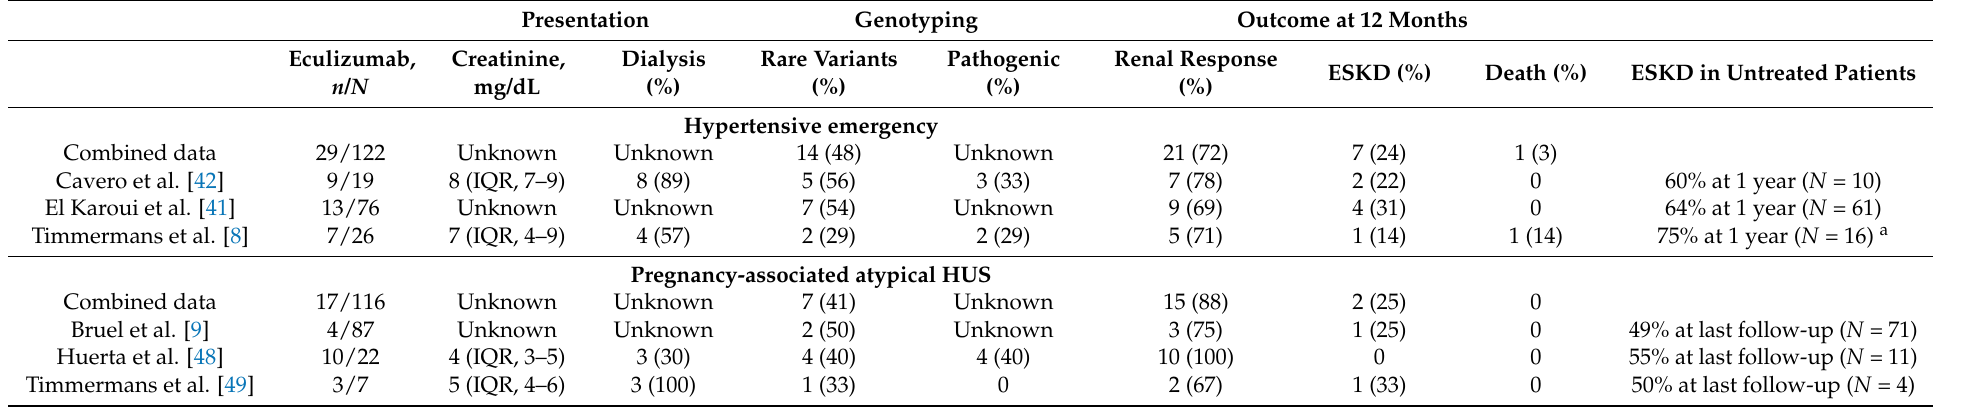
Table 1. The effects of therapeutic complement inhibition in patients with TMA and coexisting hypertensive emergency or pregnancy. Single case reports have not been